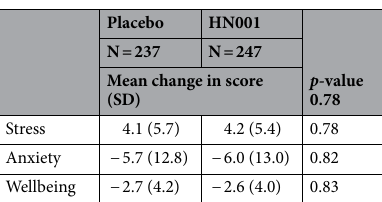
Table 2. Mean change in stress, anxiety, and psychological wellbeing for the probiotic and placebo